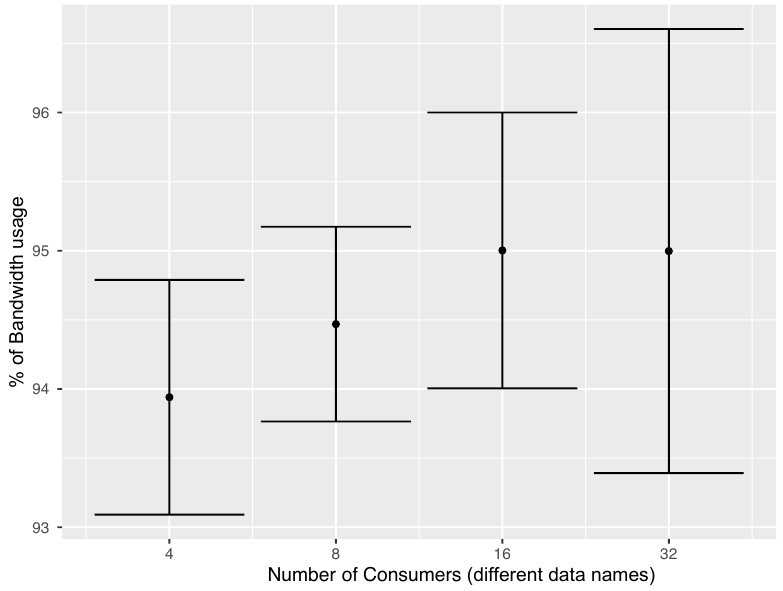
Figure 5. Percentage of bandwidth usage at the producer when consumers require different data names.